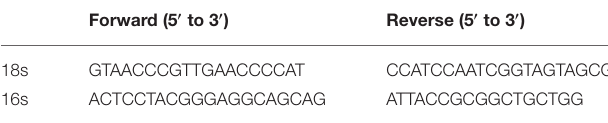
TABLE 1 | List of primer pairs used for qPCR